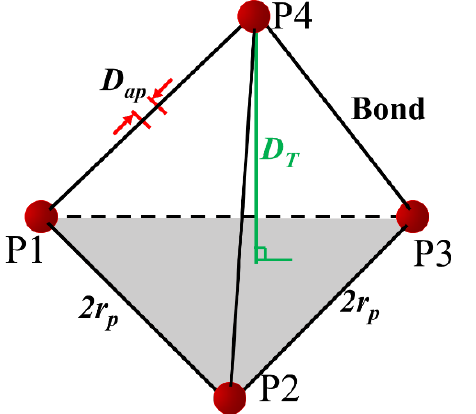
Figure 11. Illustration of the relation between crack width and direct contact aperture.